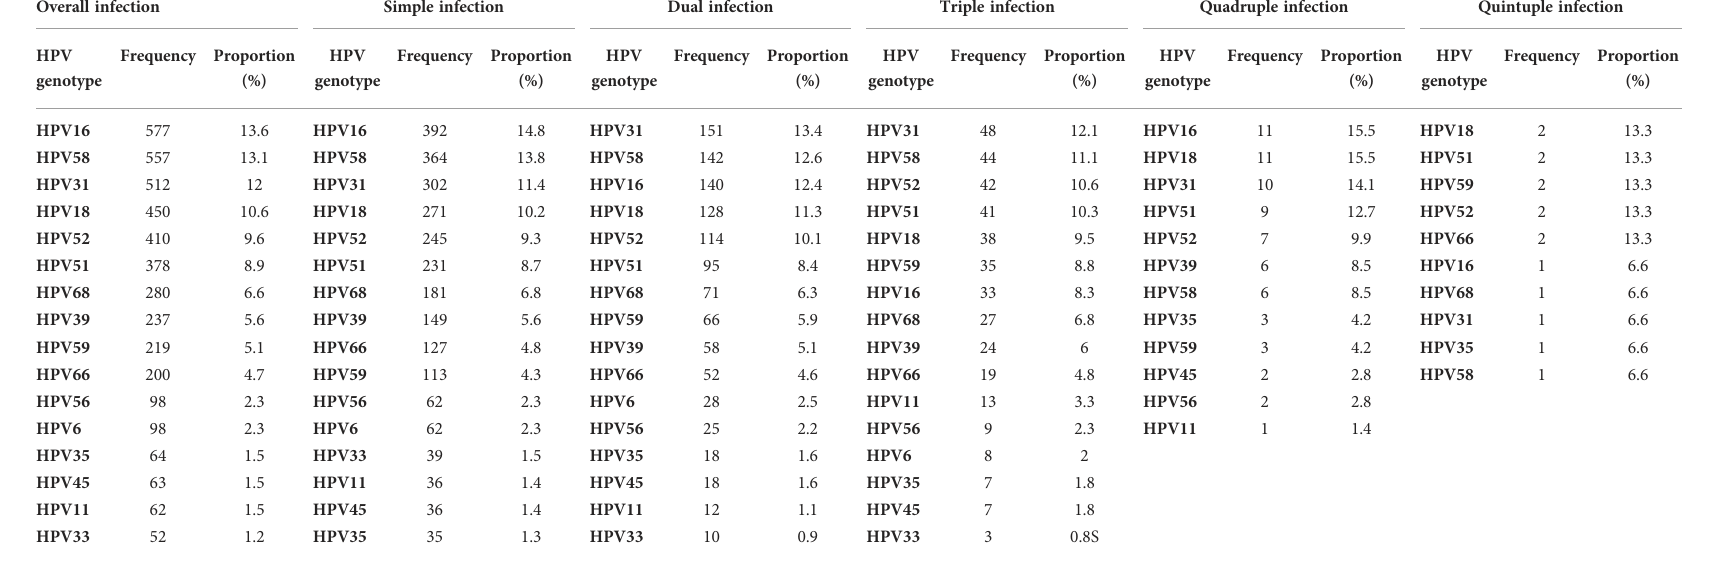
TABLE 1 Prevalence of HPV genotypes in all patients and prevalence of HPV genotypes in simple- and multiple-HPV-infection patients. Overall infection Simple infection Dual infection Triple infection Quadruple infection Quintuple